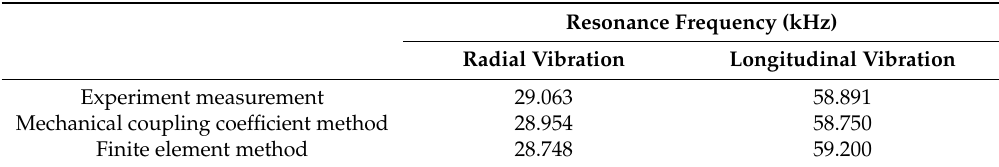
Table 2. Comparison of resonance frequencies from different methods.